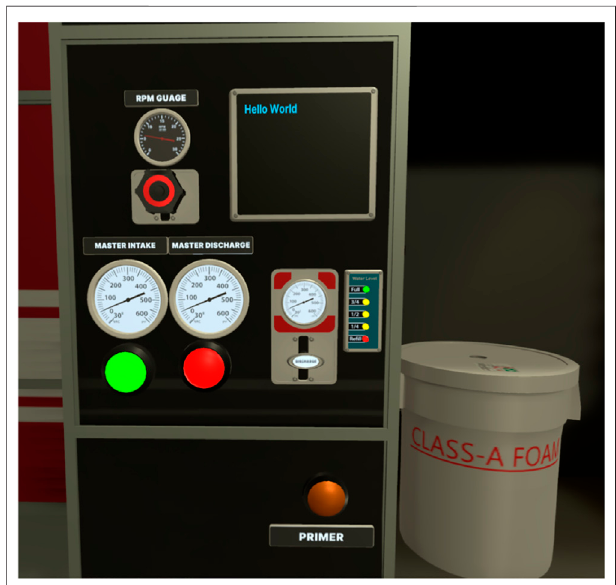
FIGURE 3 | A fi re truck panel in VR. Image courtesy of Haskins et al. (2020).